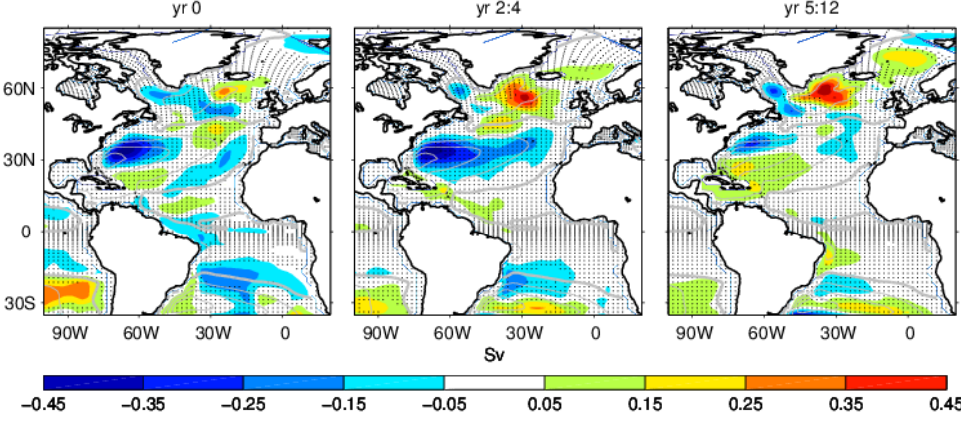
Fig. 10. Composites of anomalous Atlantic barotropic streamfunction in phase with the volcanic eruption (left) and following the volcanic eruption (other panels) for the period after 1400 A.D. Positive (negative) values correspond to an anticyclonic (cyclonic) circulation. Grey lines show the annual mean stream function in the model, with a contour interval of 10Sv . yr 0